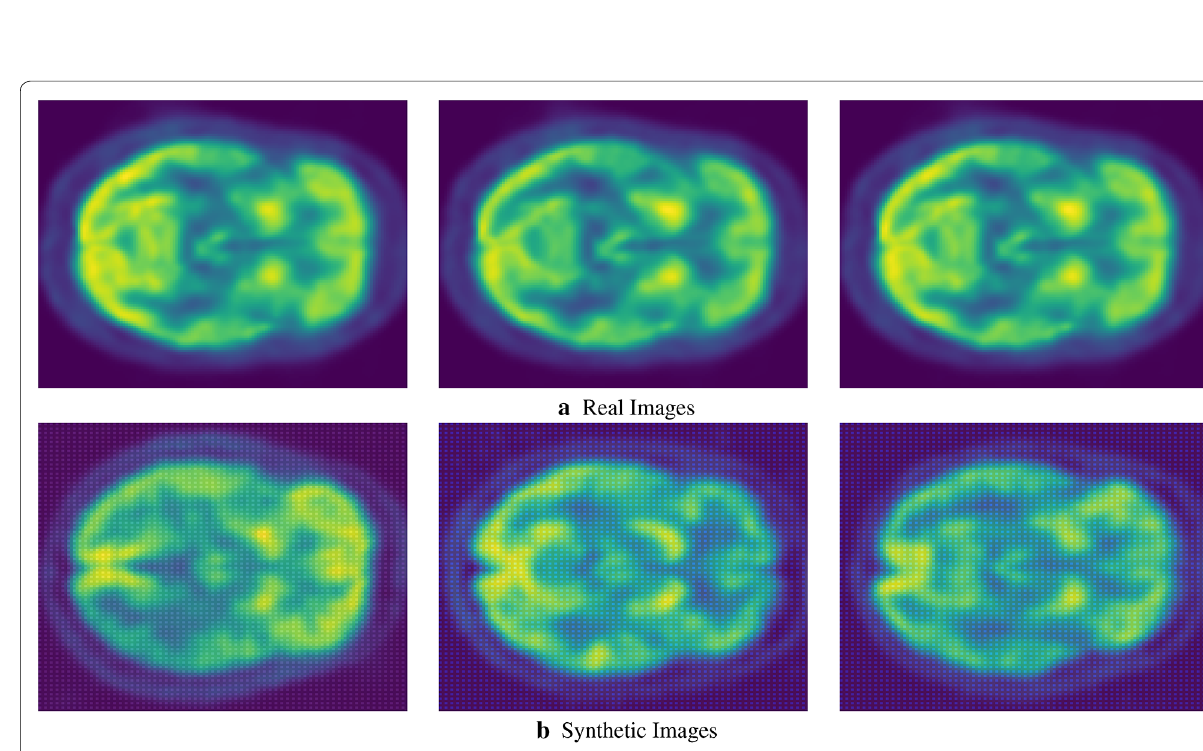
Fig. 7 Real and synthetic brain PET images of MCI patient: a real b